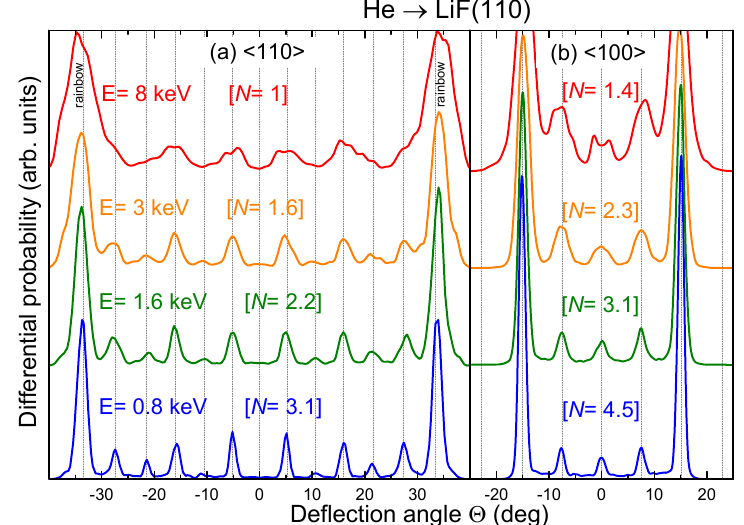
Figure 3. (Color online) Angular spectra, as a function of the deflection angle Θ , for the cases considered in Figure 2. Dashed vertical lines indicate the angular positions of Bragg